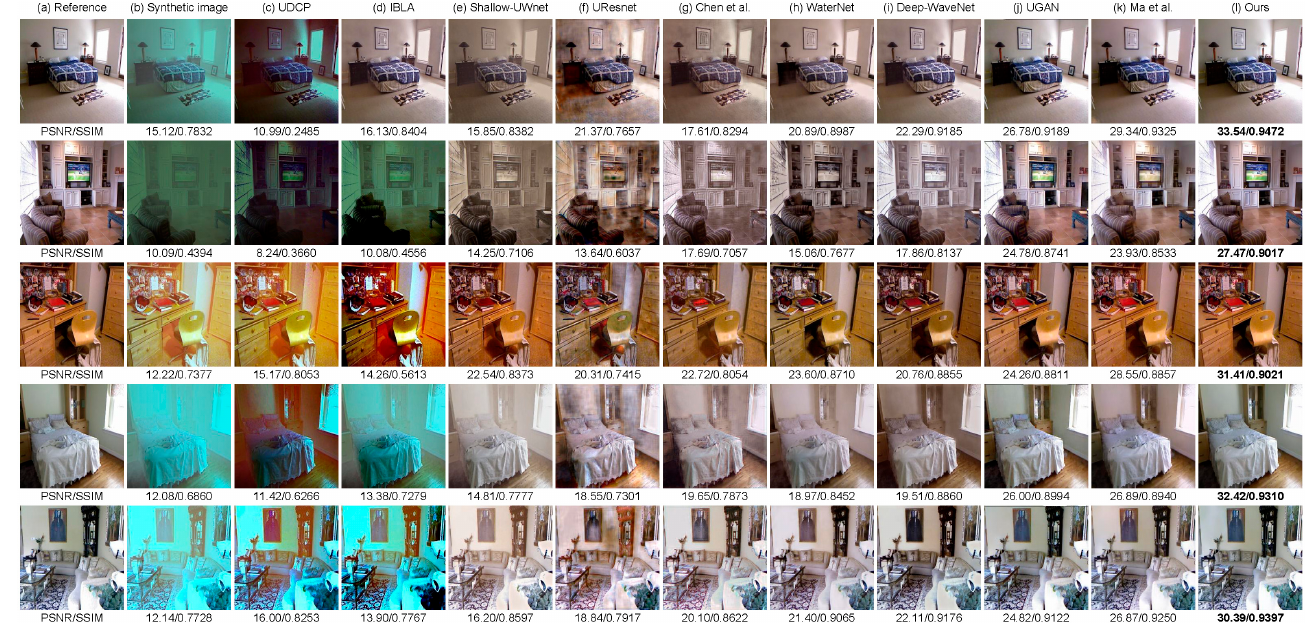
Figure 6. Visual comparisons of synthetic underwater images.